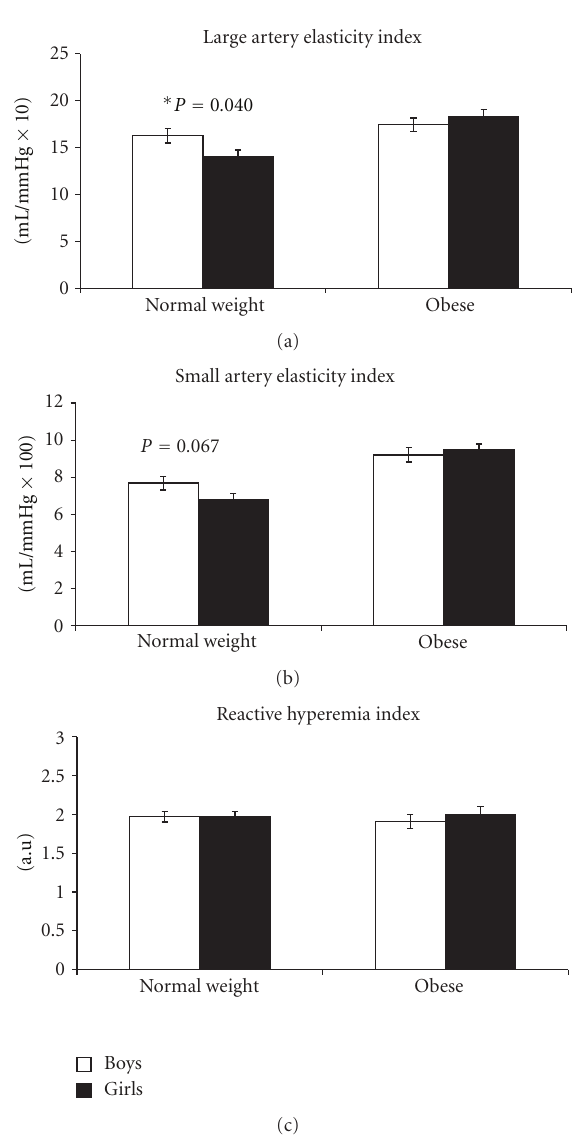
Figure 1: Reactive hyperemia index (RHI) and large and small arte- rial elasticity index (LAEI and SAEI, resp.) in boys and girls. Values are for mean ± SEM of normal-weight and obese groups. LAEI was significantly increased in the normal-weight boys compared to the normal-weight girls. SAEI was not di ff erent in boys and girls, but in the normal-weight group, the di ff erence approached significance ( P = 0 . 067). There was not a sex di ff erence for RHI in either weight group. ∗ Boys > girls in the normal-weight group ( P < 0 . 05).